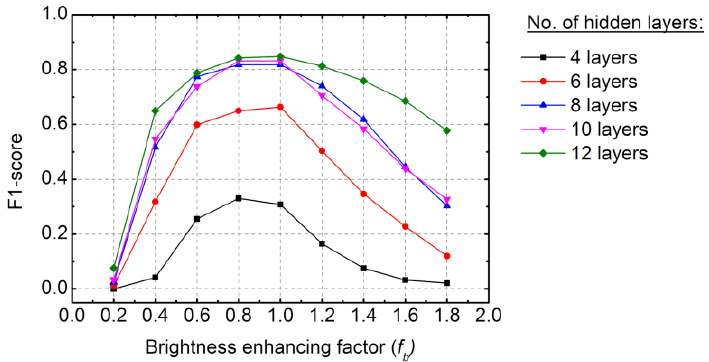
Figure 6. F1-score with different hidden layers and brightness enhancing factors.